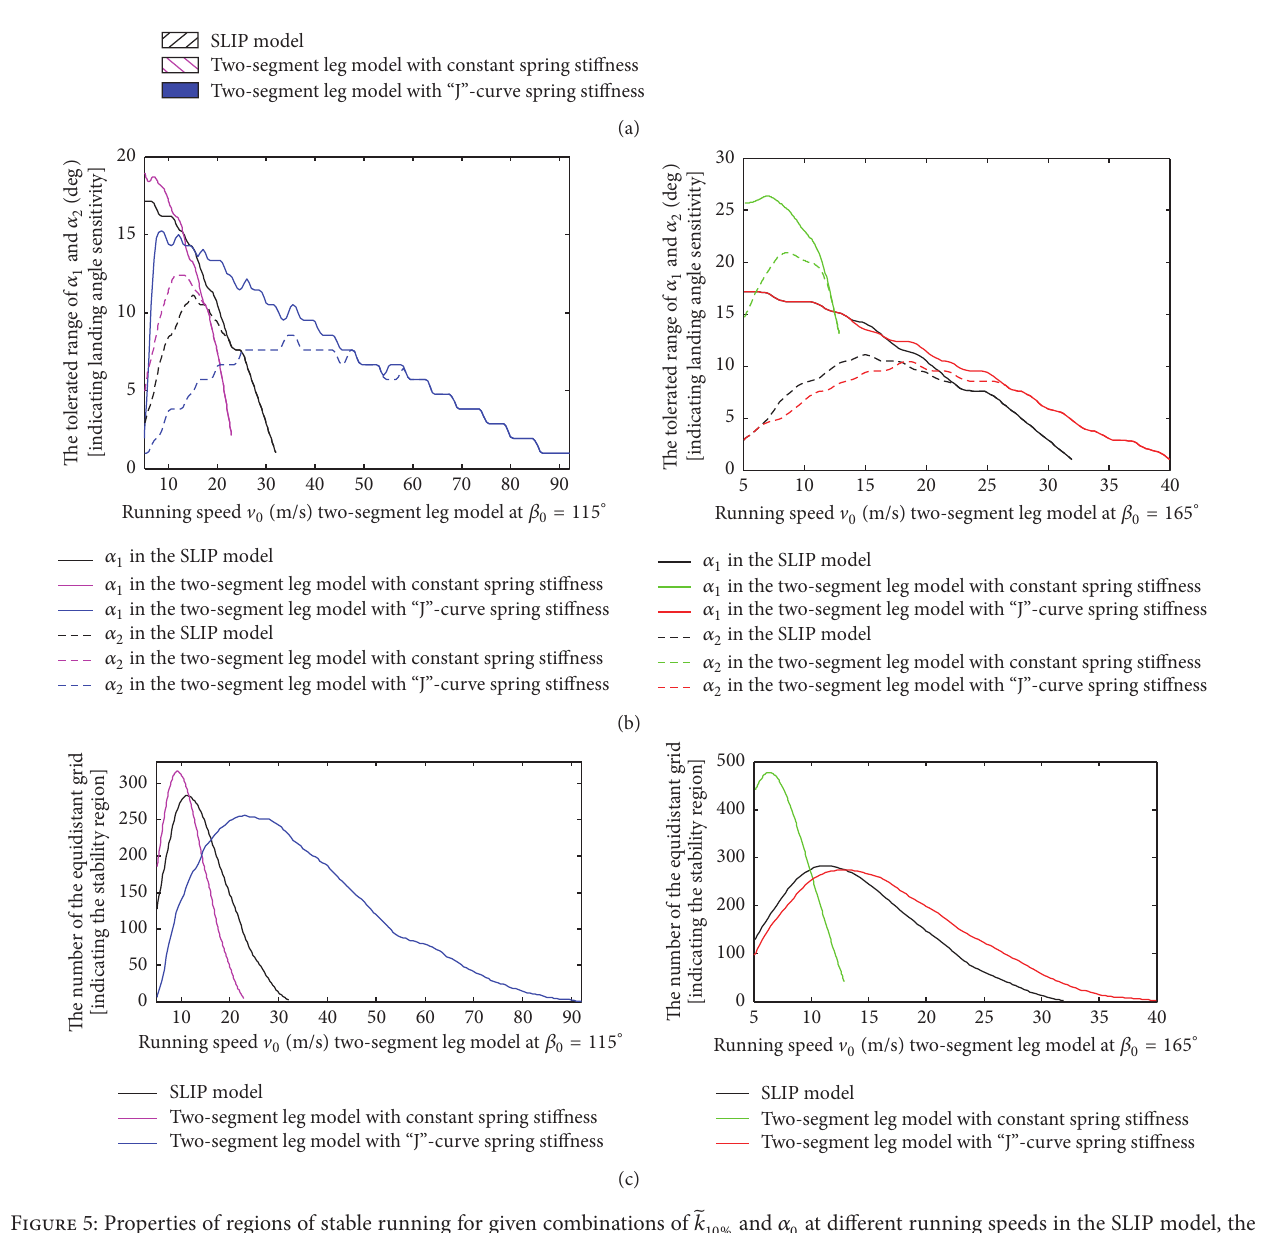
Figure 5: Properties of regions of stable running for given combinations of two-segment leg model with constant spring stiffness and with “J”-curve spring stiffness, respectively. Here, the speed range of stable running ̃ 𝑘 for a given 10 % from 0 to 50 is shown in (a) and (b), is the maximum tolerated range of landing angle on a region of stable